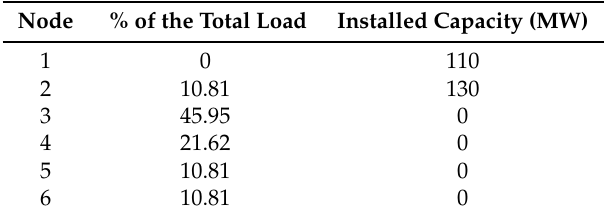
Table 1. Load demand and installed capacity in the nodes of the RTS [34].